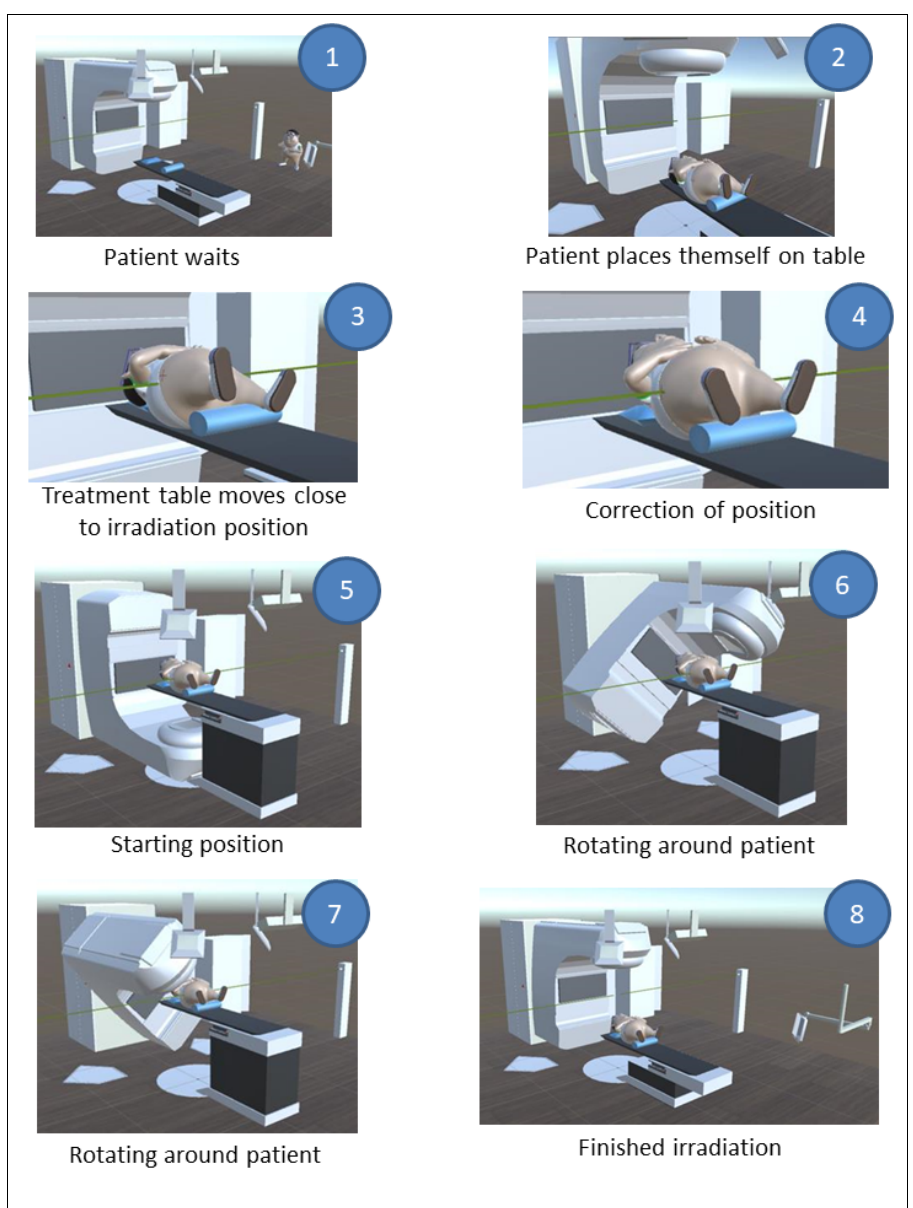
Figure 2. Sequence of the patient information of